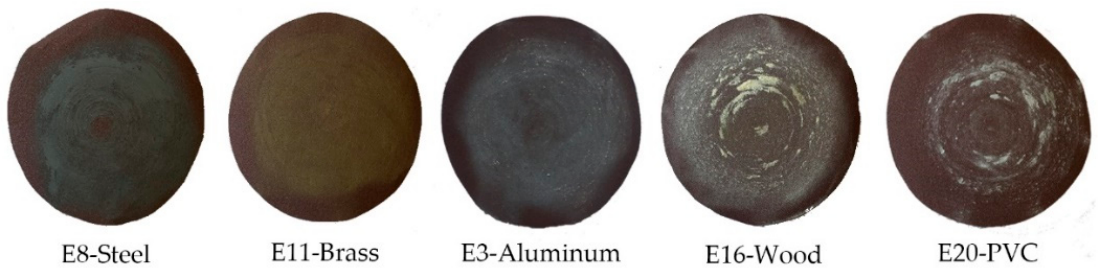
Figure 3. The surface appearance of sanding discs.